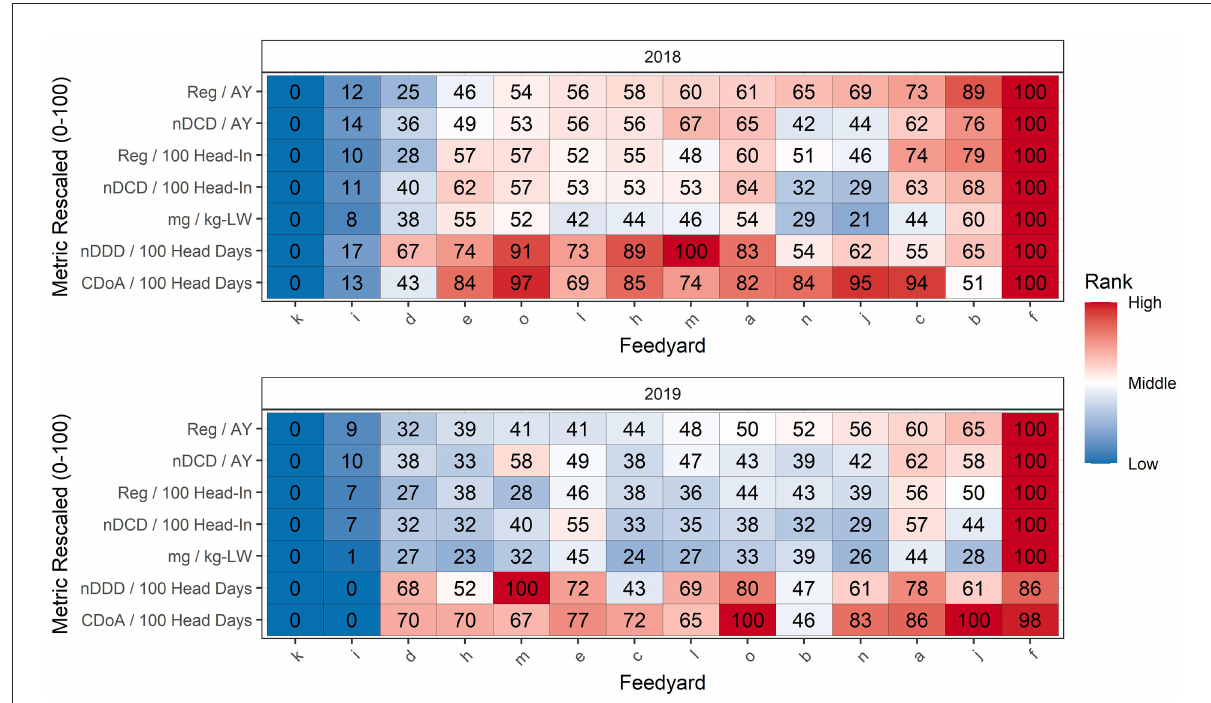
FIGURE9 Comparison of feedyard antimicrobial use ranking by 7 metrics rescaled to be expressed as proportional ranks. The feedyards are ranked on the X axis by their rank according to Reg/AY. Color coincides with numerical rank within each metric (row) as illustrated to the right of the figure.